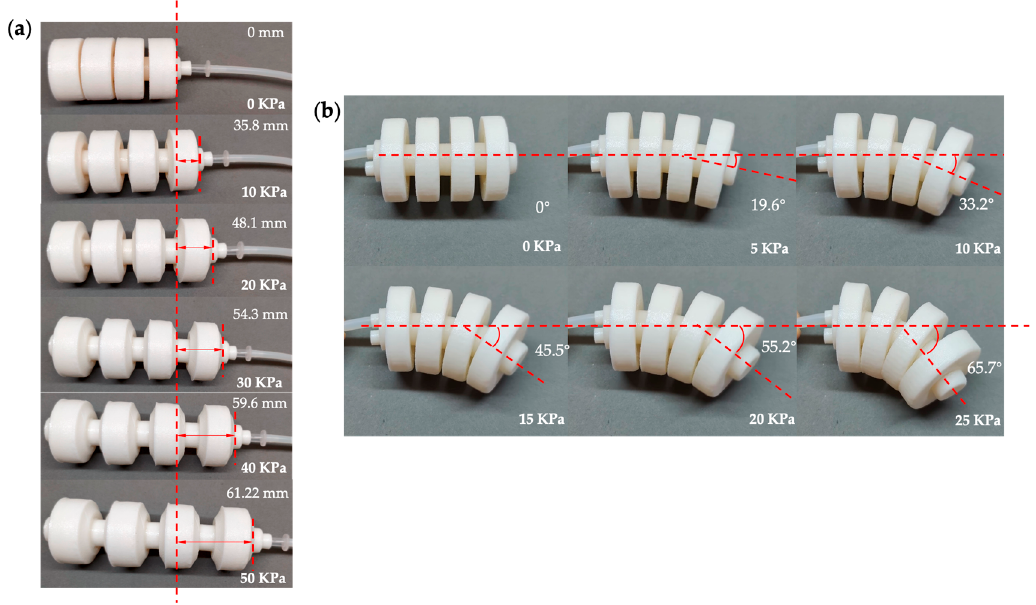
Figure 17. Testing of the actuators. ( a ) Single-channeled actuator. ( b ) Double-channeled actuator.